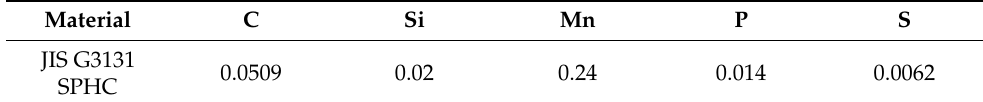
Table 1. Chemical composition of JIS G3131 SPHC steel.